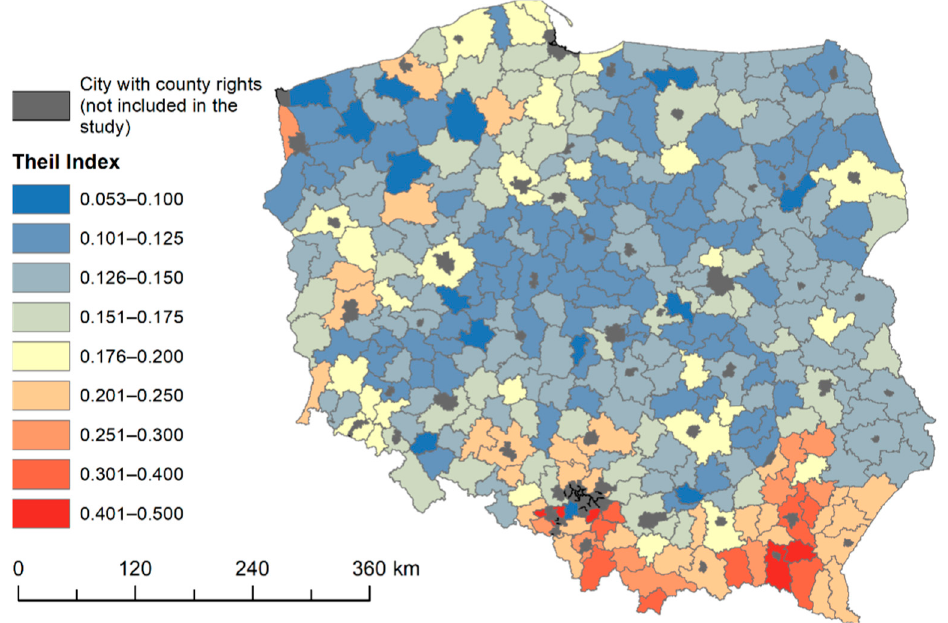
Figure 4. Theil Index for primary healthcare facilities.